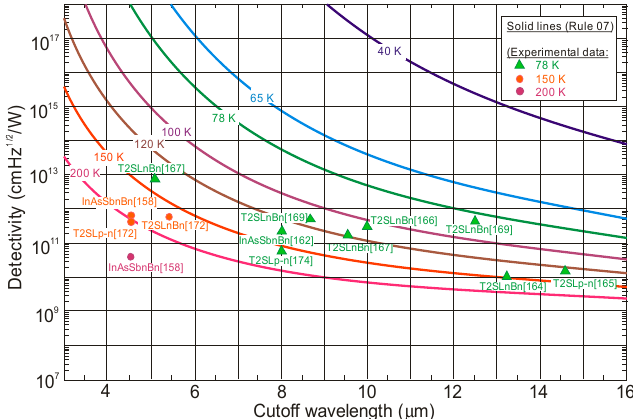
Figure 56. The simulated detectivity of the P-on-n HgCdTe detectors (Rule 07, QE = 70%) versus λ cut-off and temperature. The experimental data is taken with different sources (as marked) for InAs/InAsSb T2SL photodetectors operating at 78 K, 150 K, and 200 K.